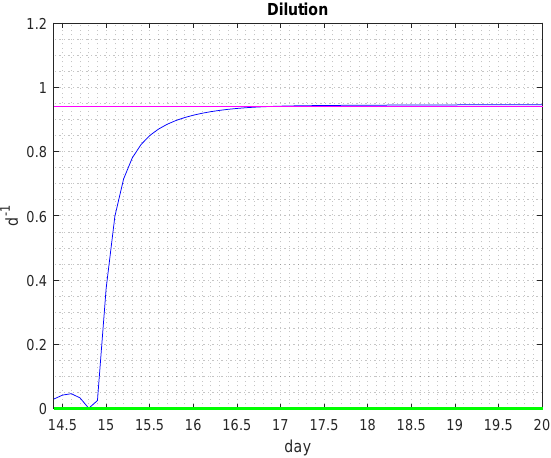
Figure 6: The behaviour of the optimal dilution rate regarding AR criterion >